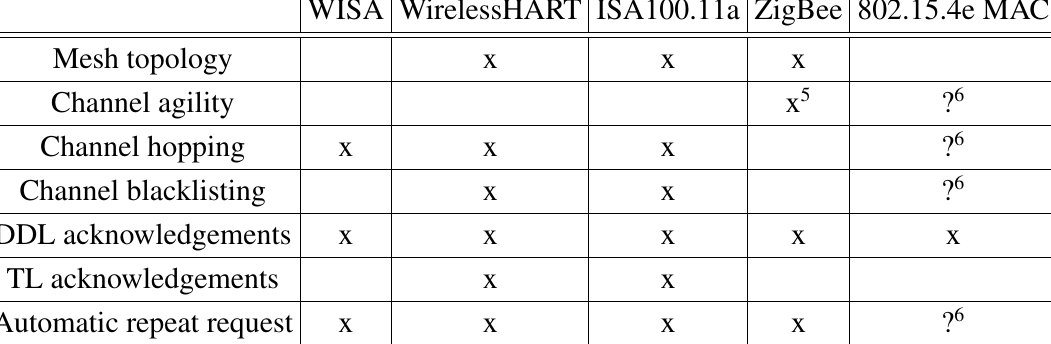
Table 4. Features relevant for robust/reliable